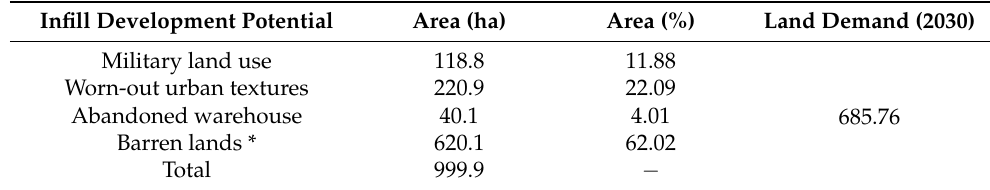
Table 6. The calculated brownfield sites that have the potential to be used as infill development. Infill Development